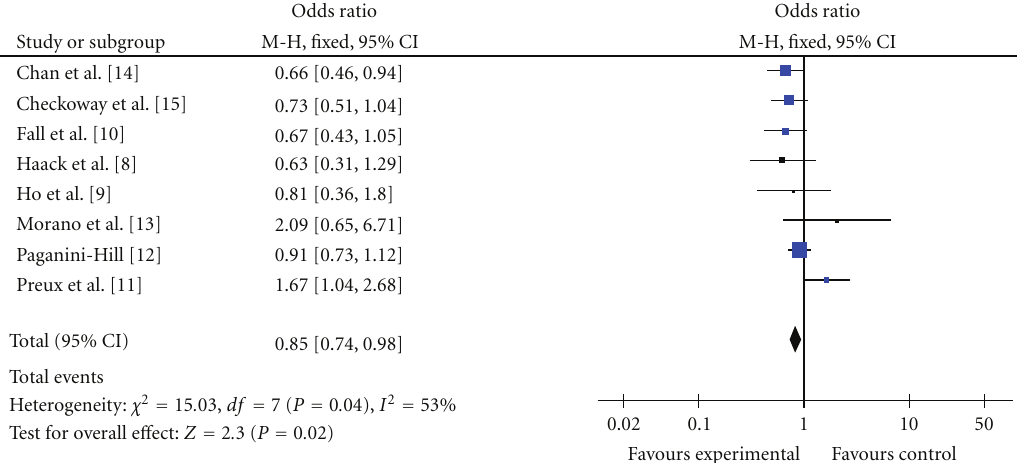
Figure 2: Pooled estimate of OR and 95% CI of PD risk for tea drinking. Blue diamonds indicate adjusted OR in each study. Open diamonds are pooled OR. Horizontal line represents 95% CI. Studies are ordered by alphabetical order of last name of first